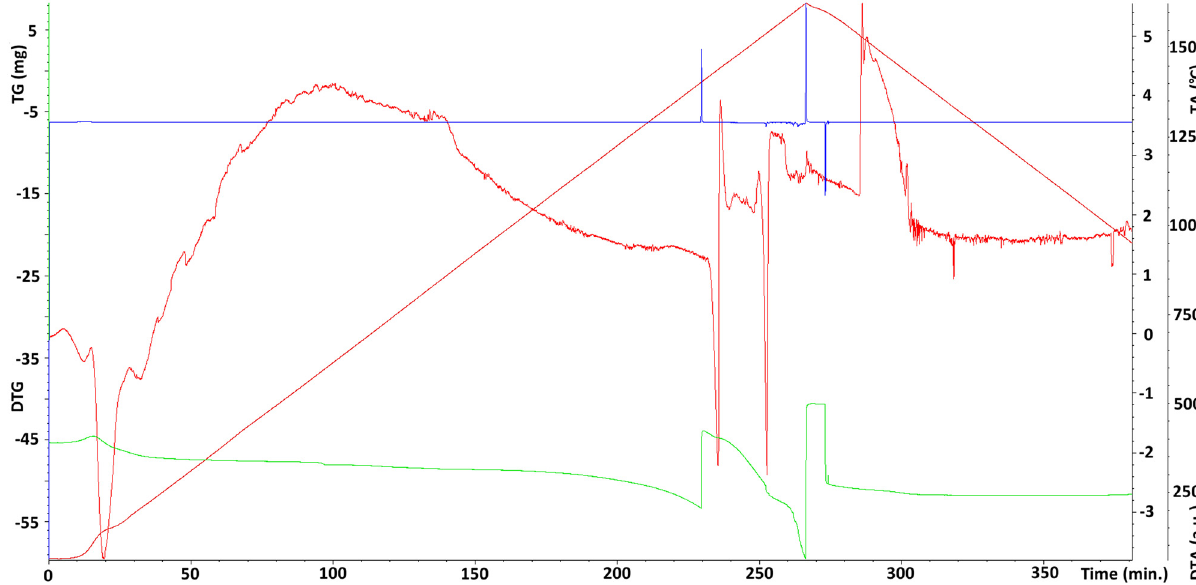
Figure 8: Di ff erential thermal analysis of the Ni – 37Re coating; brown line – ( TA ) temperature change over time in °C; red line – ( DTA ) di ff erential thermal analysis temperature di ff erence between the tested material sample and the reference material; green line – ( TG ) change of sample mass; blue line – ( DTG ) mass change rate )